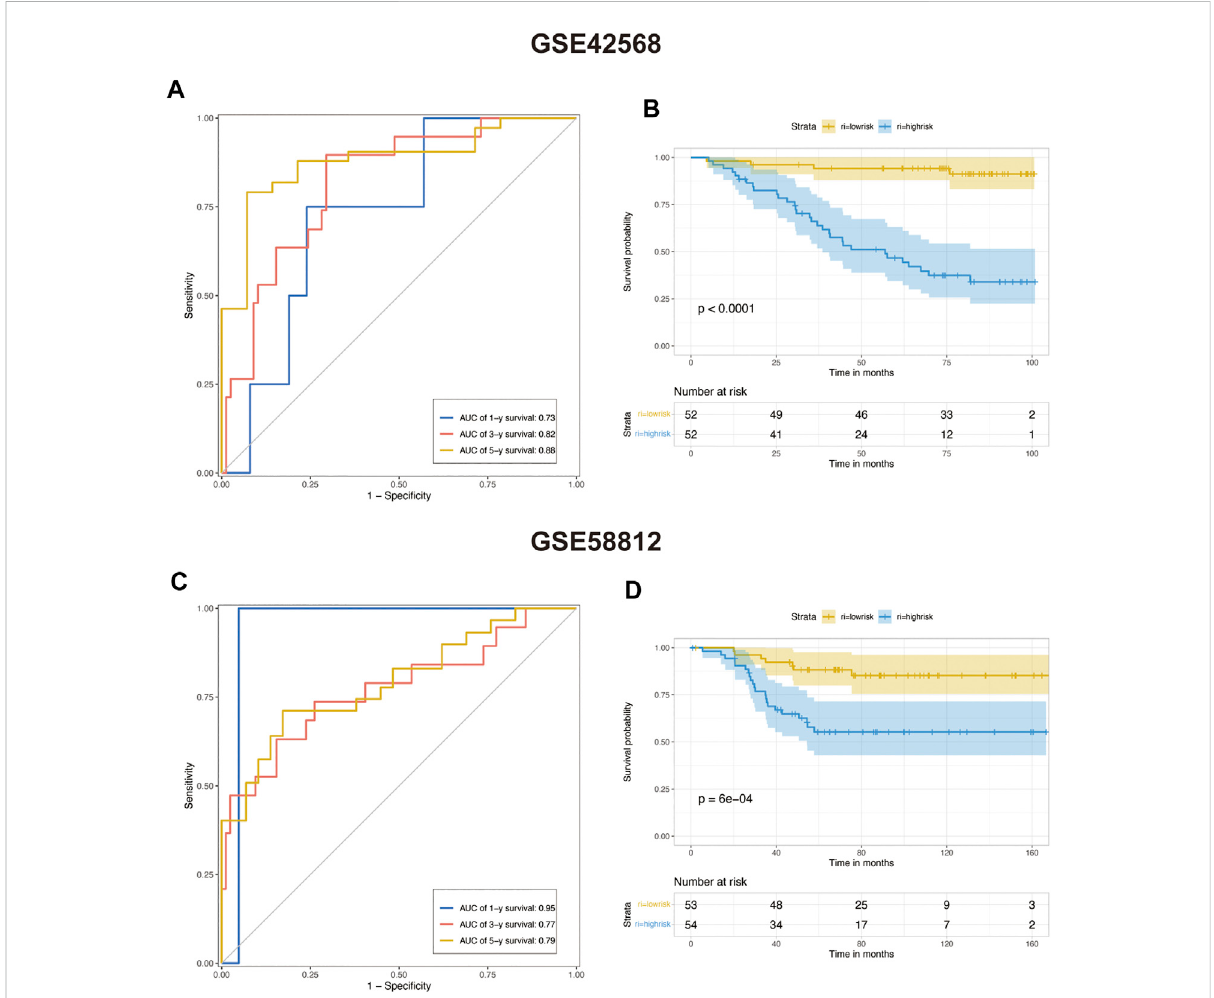
FIGURE 6 Predicting the ef fi cacy of constructed multivariate Cox regression in the testing set. (A) COX risk score ’ s time-dependent ROC curves for 1, 3, and 5 years before death in testing cohort GSE42568. (B) Kaplan – Meier survival analyses for COX low- and high-risk groups in testing